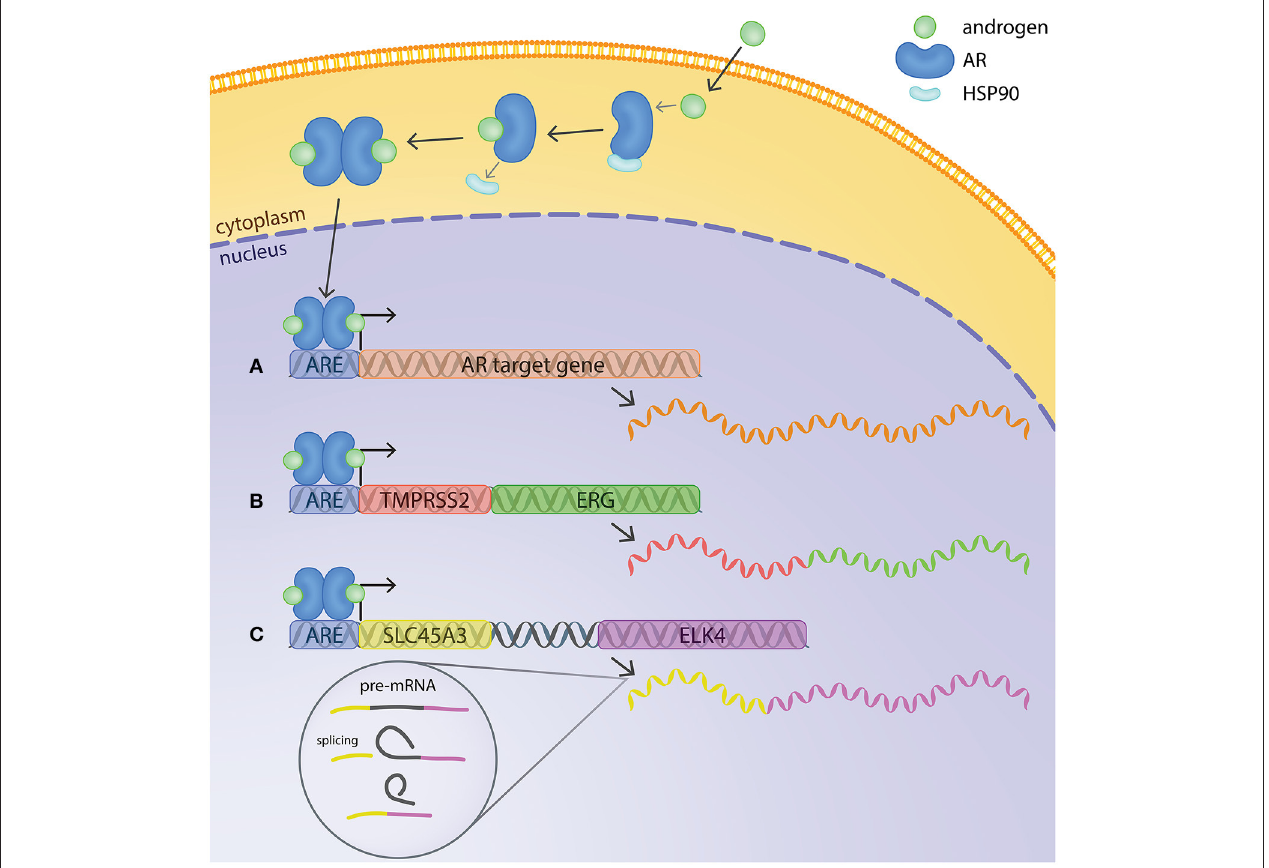
FIGURE 1 | Mechanisms of androgen regulation of gene expression in prostate cancer cells. In its inactive form, AR is located in the cytoplasm bound to HSP90. The binding of androgens induces a conformational change in AR, releasing Hsp90 and enabling translocation of AR to the nucleus. AR binds to androgen response elements (AREs) at the promoter or enhancer regions of androgen-regulated genes and regulates host gene transcription. (A) Example of a typical androgen-regulated gene, expression of which is induced when AR binds to the ARE at the promoter region. (B) TMPRSS2:ERG fusion gene at chromosomal level and mRNA transcript. The ARE on TMPRSS2 brings ERG under transcriptional regulation of AR. (C) SLC45A3 and ELK4 are located adjacently in the same chromosome. Transcription by RNA-polymerase readthrough and mRNA splicing generates SLC45A3:ELK4 fusion